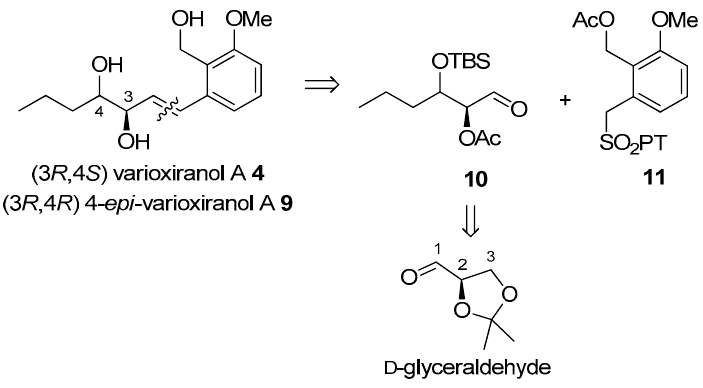
Scheme 1. Retrosynthetic analysis of 4 and 9